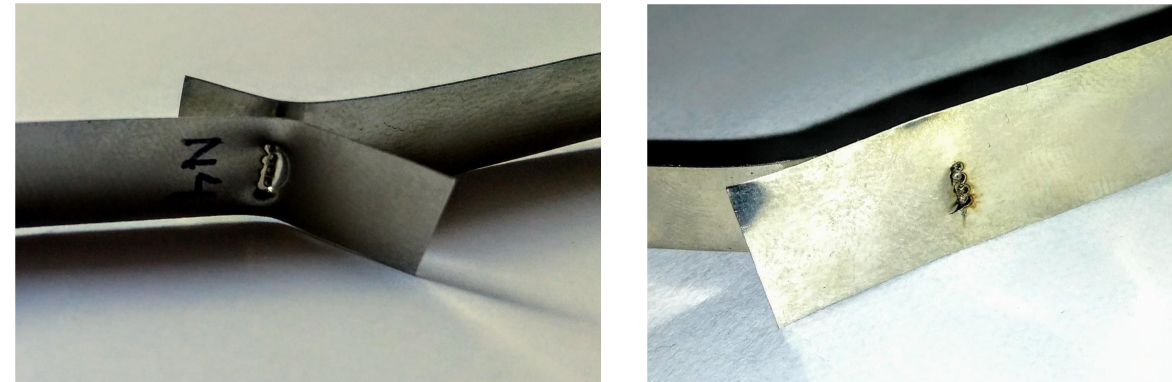
Figure 6: Samples with a four-spot weld broken on the testing machine: Ni/Ni joint on the left, 0H18N9/Ni joint on the right.